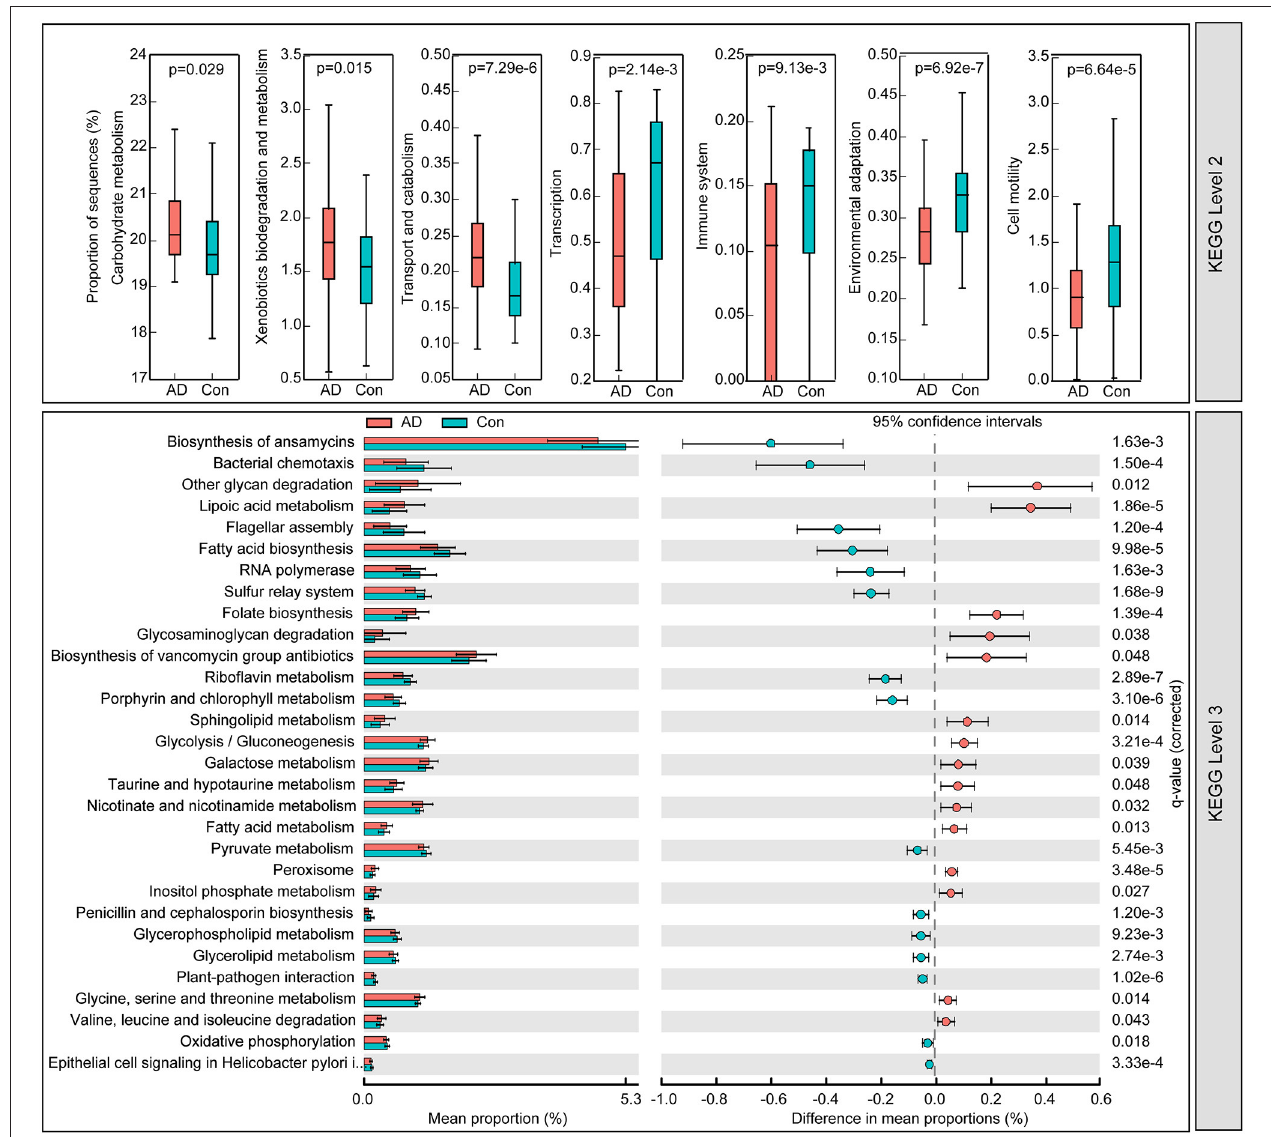
FIGURE 5 | PiCRUSt-based examination of the fecal microbiome of the Chinese AD patients and the healthy controls. The different bacterial functions were evaluated between them based on two-sided Welch’s t -test. Comparisons between the groups for each KEGG functional category (levels 2 and 3) are shown by percentage. The Benjamini–Hochberg method was used for multiple testing correction based on the false discovery rate (FDR) through